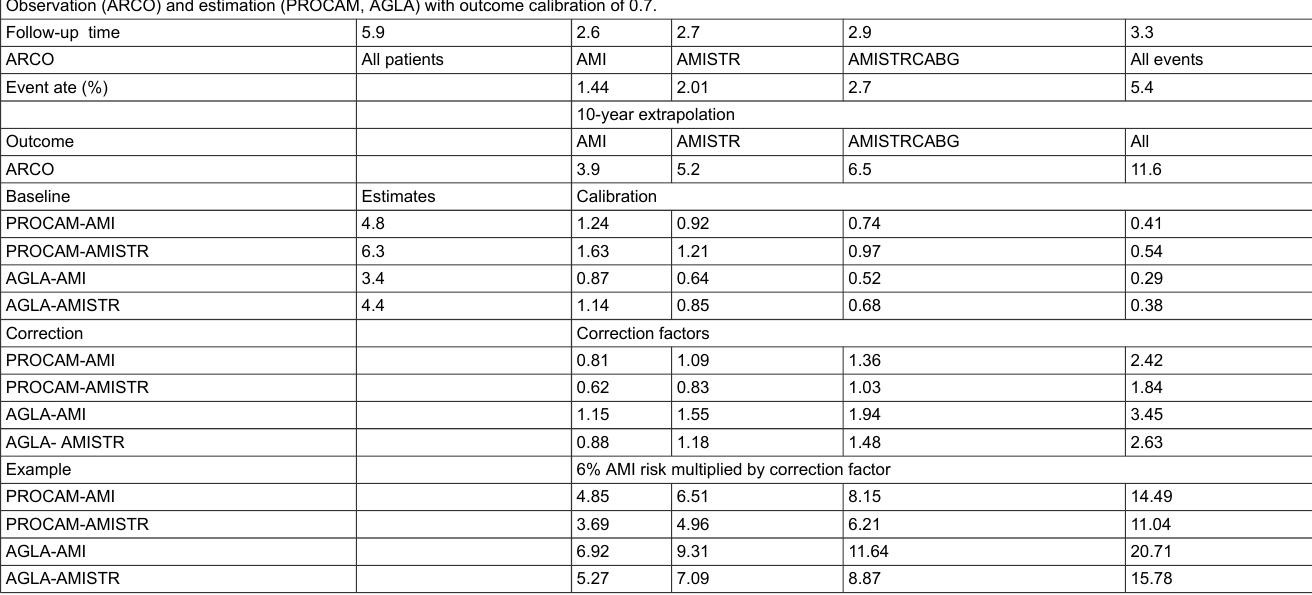
Table 3: Calibration factors for PROCAM and AGLA to detect events from the ARCO cohort with event rates extrapolated to 10 years for various outcomes separately (AMI, AMI + STR, AMI + STR + CABG, All). Outcome was multiplied by 0.7 to reflect the expected risk in Switzerland. Observation (ARCO) and estimation (PROCAM, AGLA) with outcome calibration of 0.7. Follow-up time ARCO